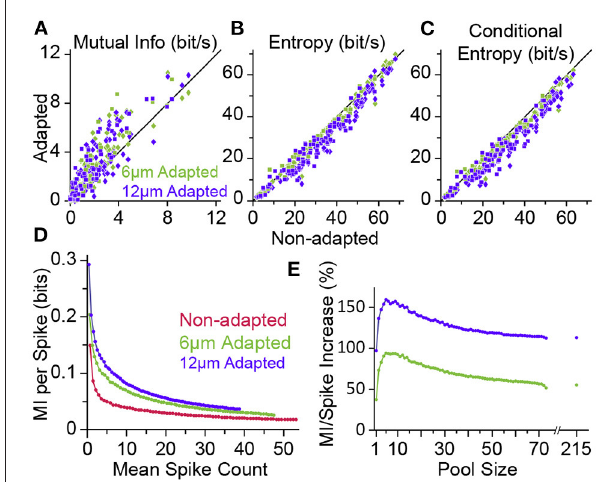
FIGURE 7 | Adaptation enhances the information content of neuronal responses. (A) Mutual information (MI) between the whole stimulus set and the neuronal responses (from Figure 3 ) in adaptation condition (ordinate, 6 µm adaptation in green and 12 µm adaptation state in magenta) versus the non-adapted state (abscissa). Each data point corresponds to a single neuron ( n = 73; square markers) or a cluster of multi-units ( n = 86; diamonds). (B) As in (A) , but plotting the response entropy of individual neuronal recordings. (C) As in (A,B) , but plotting the response entropy conditional on stimulus. (D) Adaptation increases the average information content of individual spikes. Neuronal responses from different population sizes were pooled together and plotted against the average pooled spiking for every population size. (E) Percent increase in the single spike information in the adapted states relative to the non-adapted state. Data is from (D) . The data points after the break in the abscissa include multi-unit clusters with the single-unit data. From the firing rates, we estimate that the total population consisted of ∼ 215 single units. Modified from Adibi et al.